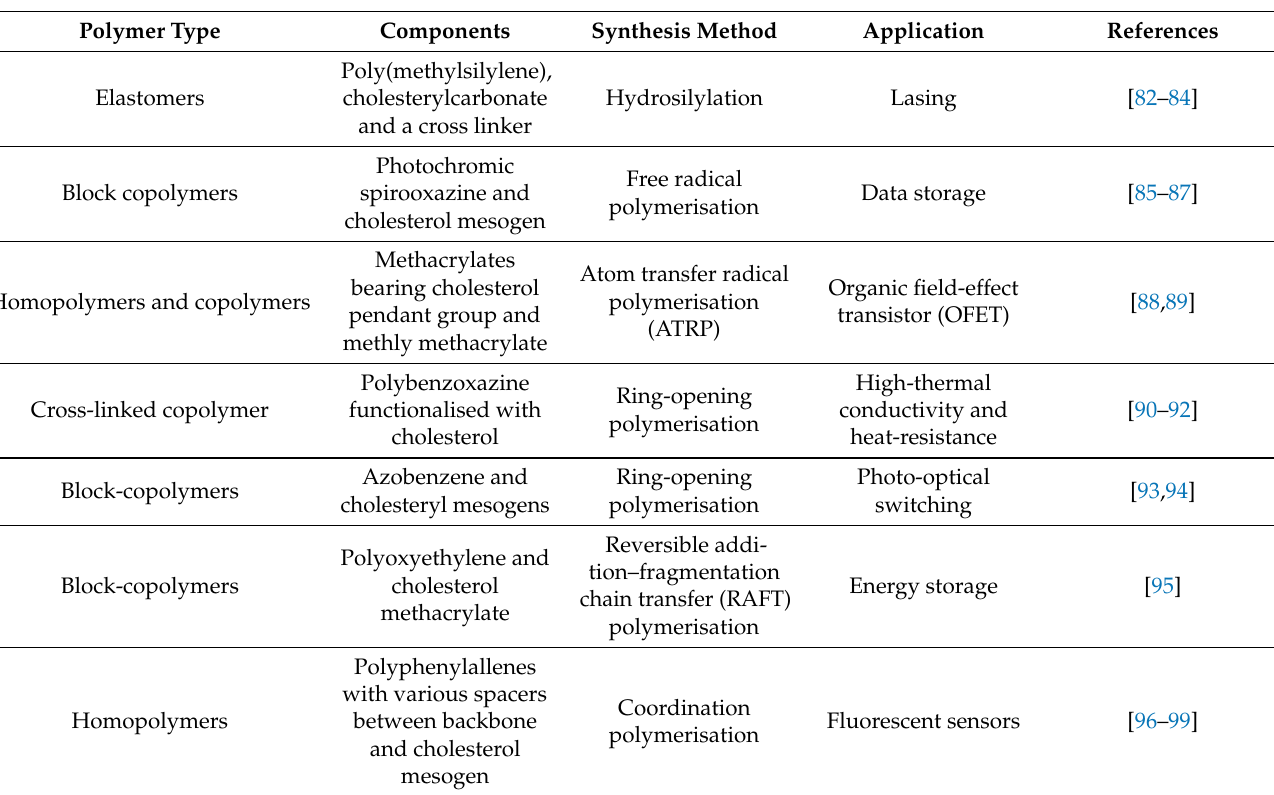
Table 1. List of various cholesterol-containing polymers and their applications in photonic and electronic